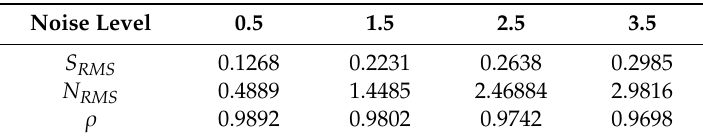
Table 2. Performance indicators of the TDMWA algorithm in di ff erent Gaussian white noise simulation environments.